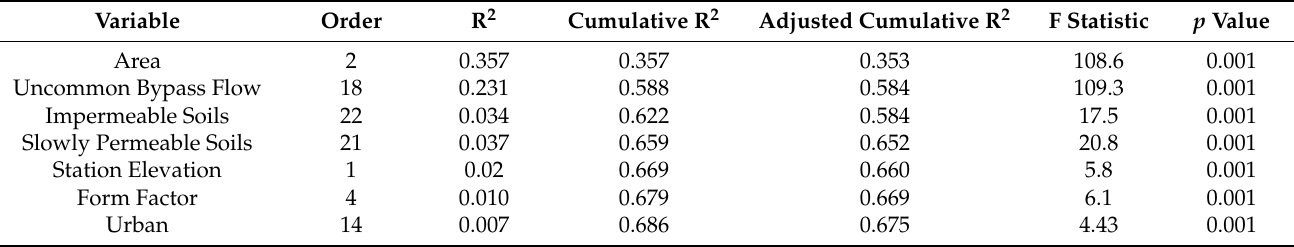
Table 2. Explanatory variables chosen during the forward selection process along with their comparative explanatory power (adjusted R2) and significance (F statistic and p Values). The explanatory variables represent the most parsimonious model and explain the most variation in the hydrological response